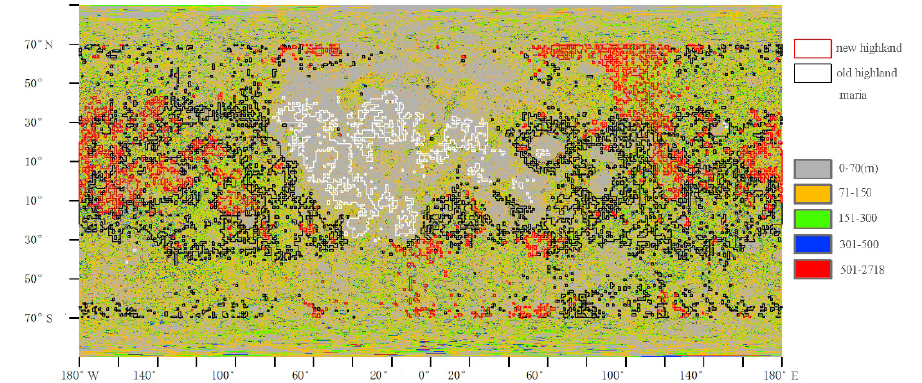
Figure 4. Globe fluctuation distribution map of the moon and the three areas. Fluctuation of ‘maria’ is between 0 and 70 m, ‘old highland’ is between 0 and 300 m, ‘new highland’ is between 0 and 500 m.